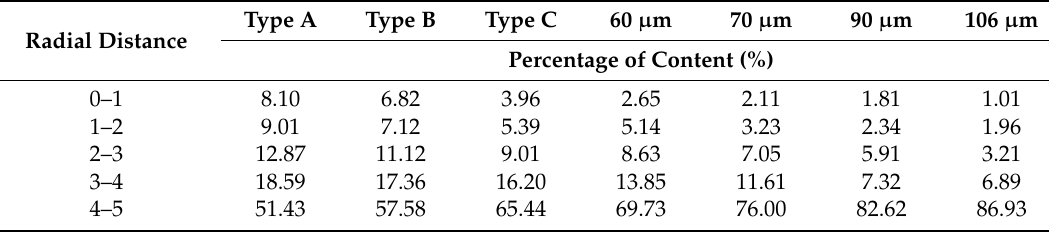
Table 6. Concentration distribution of different sand particles in the cylindrical section.